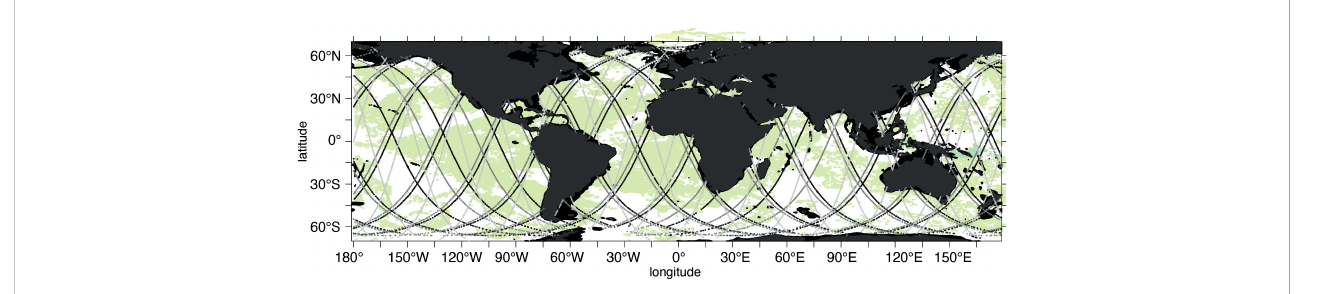
FIGURE 1 Con fi gurations of synthetic SST (shading) and SSH (curves) observations for a given day. SST maps have been masked out following the ODYSSEA L3S product. SSH sampling corresponds to the orbitals of Jason-2, Jason-3 and Sentinel-3a